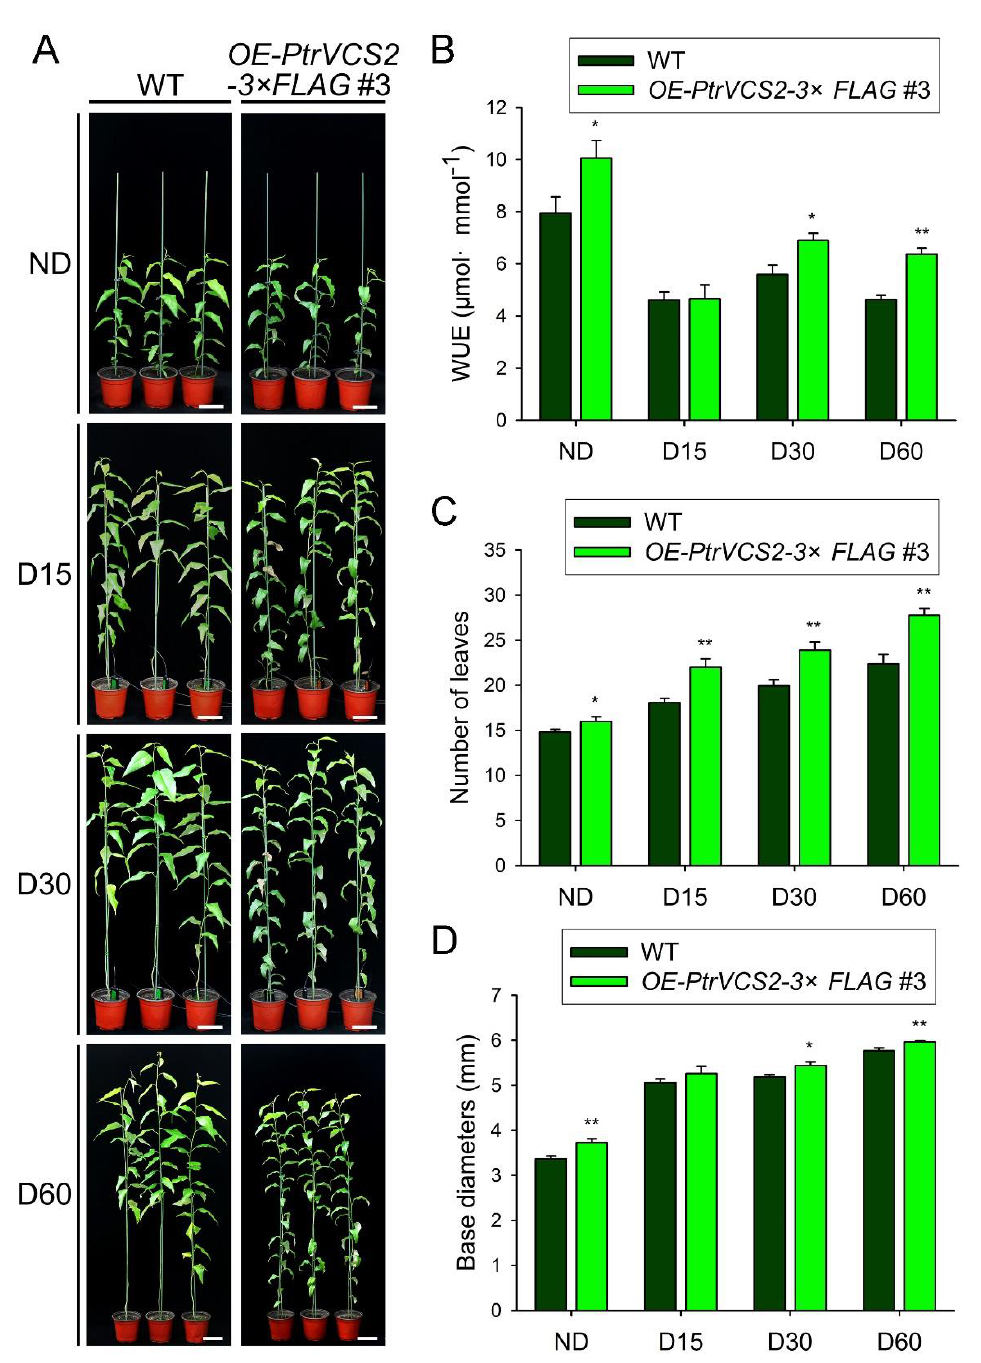
Figure 5. Overexpressing PtrVCS2 gene improves the adaptability of P. trichocarpa to chronic drought stress. ( A ) Phenotypes of the OE-PtrVCS2 transgenic and wild-type plants with chronic